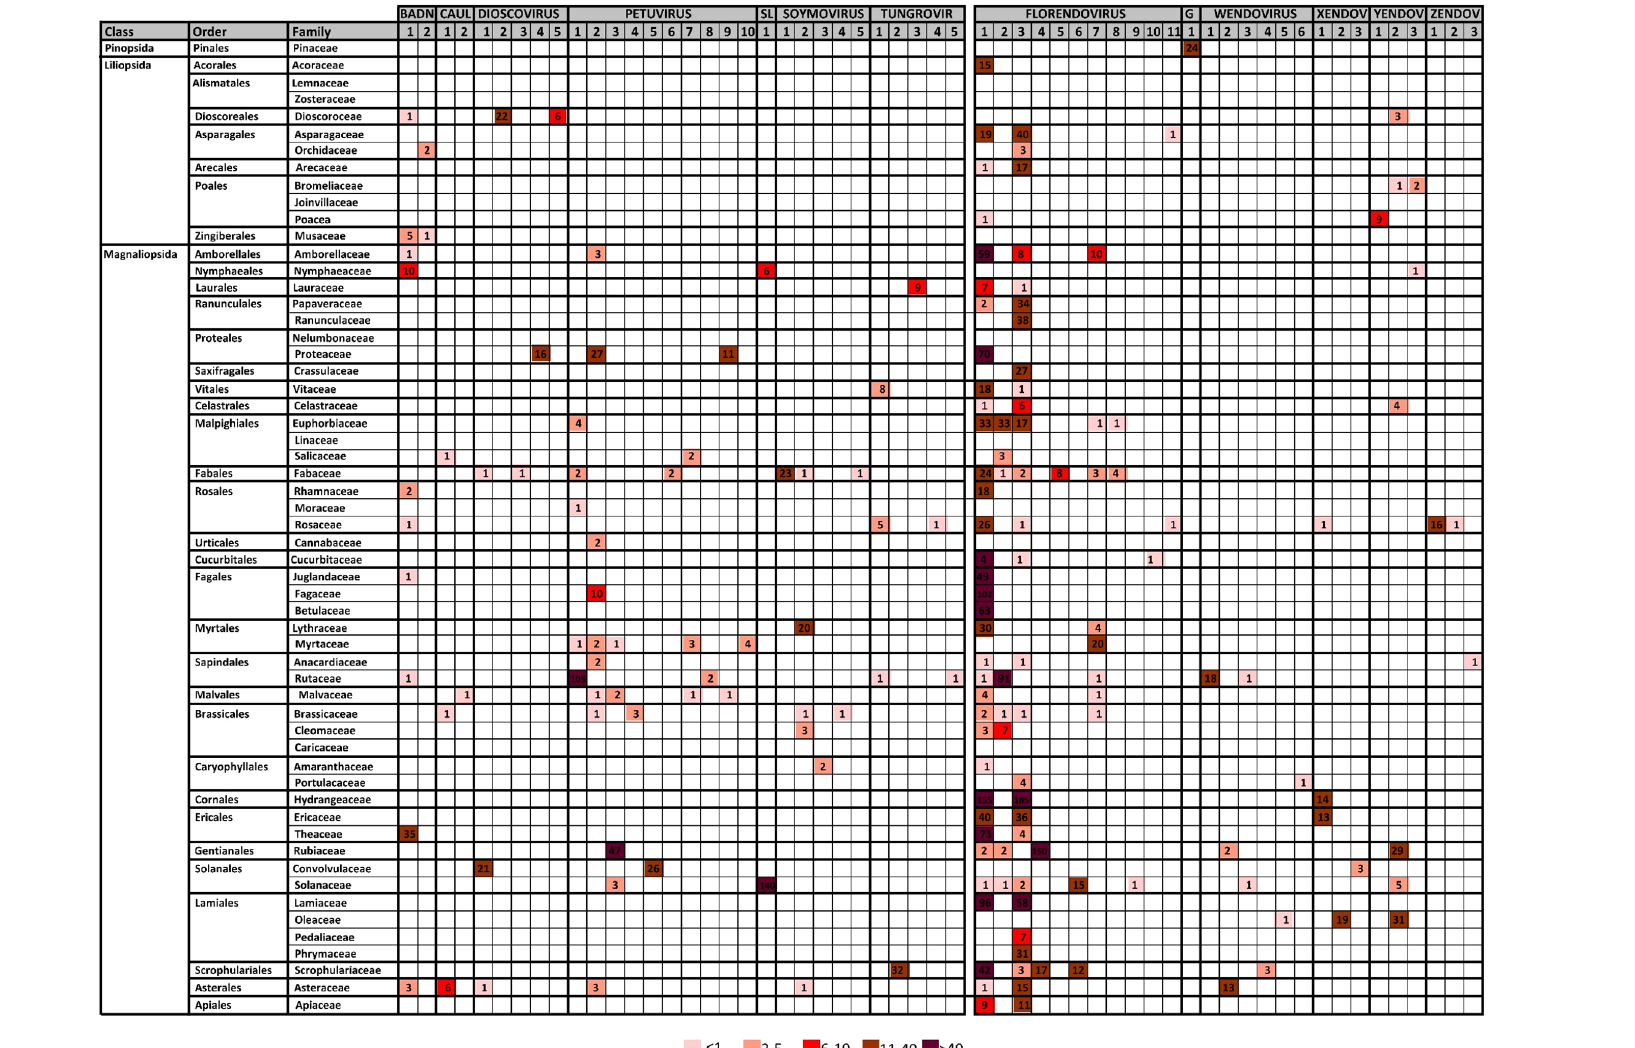
TABLE 2 Distribution of Cluster60 in plant